Question: Condense the content of this figure into a single sentence.
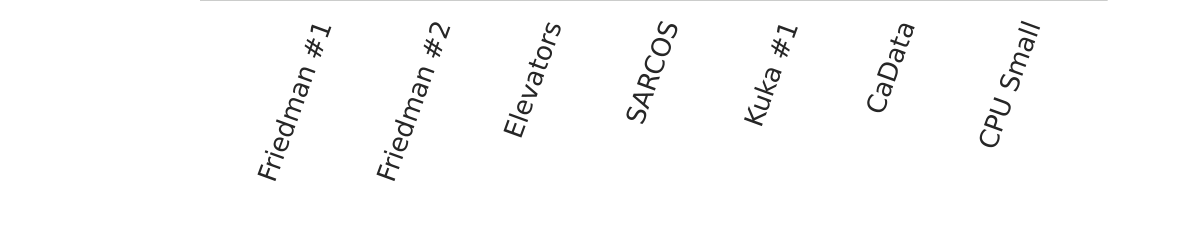
Answer: Results of Experiment 1. Pictured are the nMSE (lower is better) and PLL (higher is better) with error bars denoting one standard deviation over 10 random trials. The best-performing method on each dataset and metric is highlighted with bold edges — to preserve readability, the nMSE axis was bounded at +1.0 and the PLL axis is bound at ±2.5, even if points extend past this.